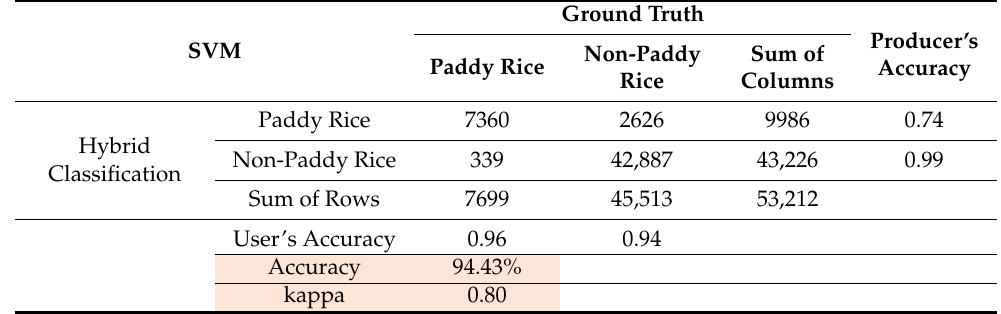
Table 7. Outcomes for hybrid